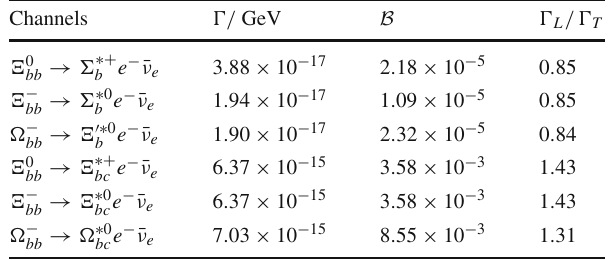
Table 11 Semileptonic decays for the bb sector